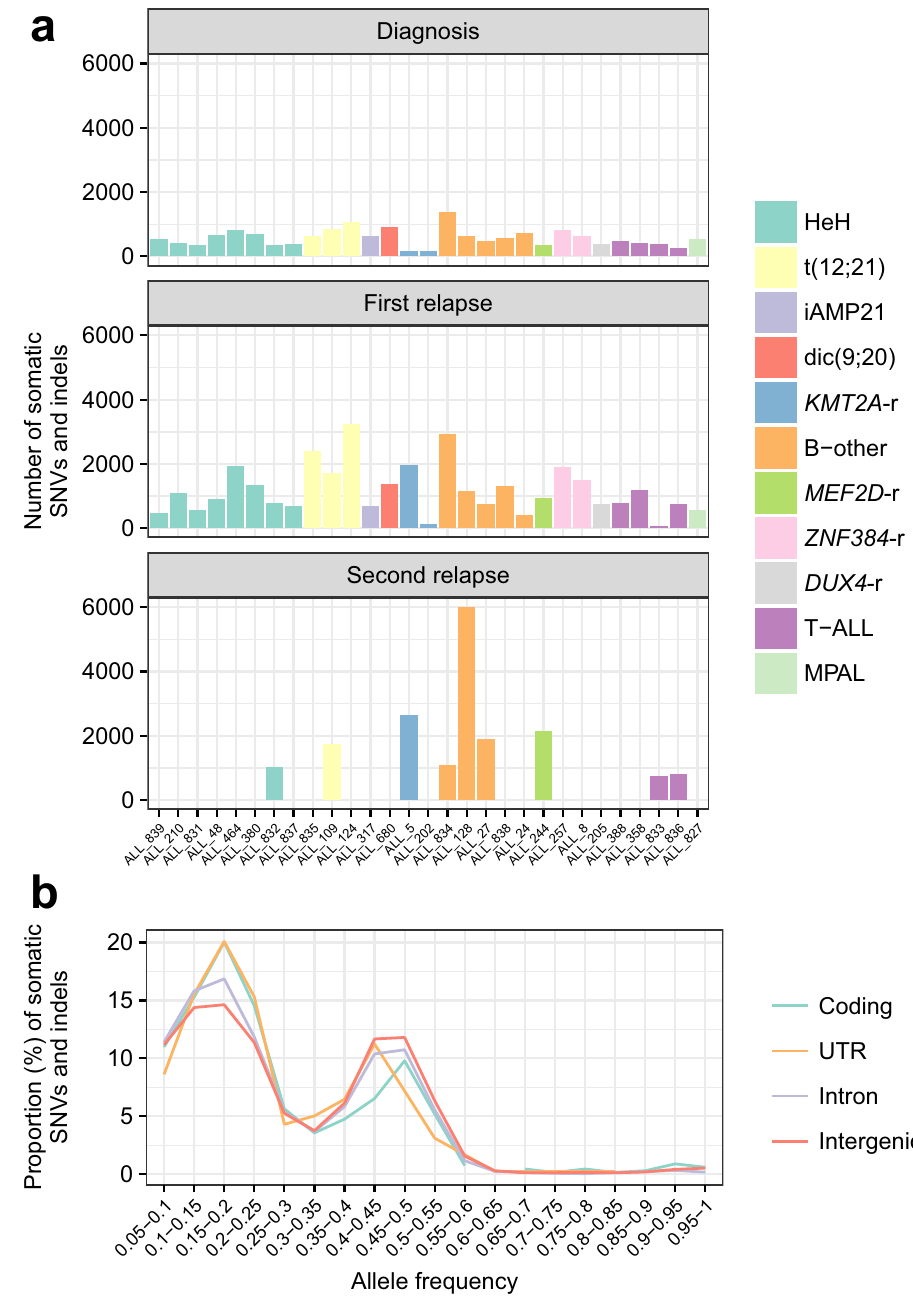
Figure 1. Distribution of somatic mutations in 29 patients with pediatric ALL. (a) Number of somatic single nucleotide variants (SNVs) and insertion/deletions in 29 ALL patients at diagnosis, first and second relapse are shown. The genetic subtypes are color-coded. (b) Allele frequency (AF) distribution of somatic mutations across genomic regions. Each region displays an AF peak between 0.35 and 0.50, which indicates mutations in the major clone, together with an AF peak between 0.1 and 0.25, which indicates subclonal mutations ( UTR untranslated